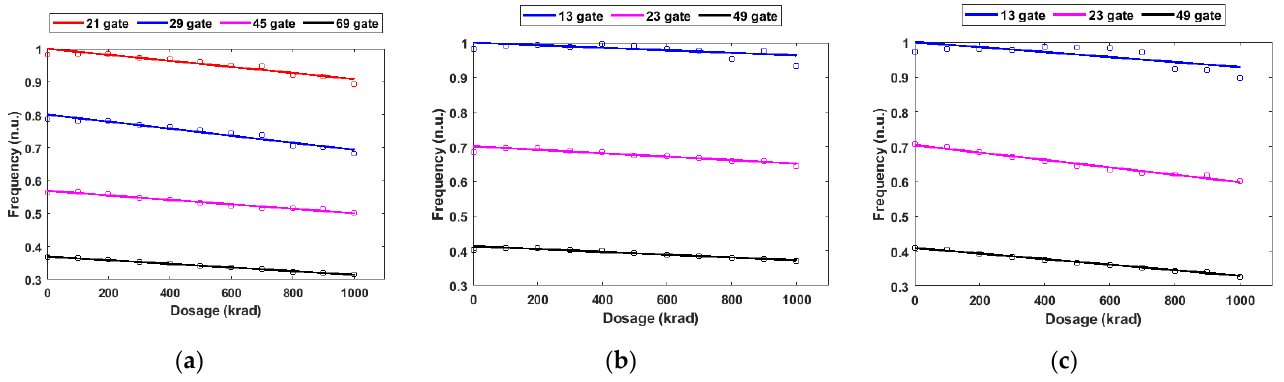
Figure 7. RO frequencies vs. total absorbed dose during Co-60 test: ( a ) Inverter-based ROs; ( b ) NAND2-based ROs; ( c ) NOR2-based ROs.